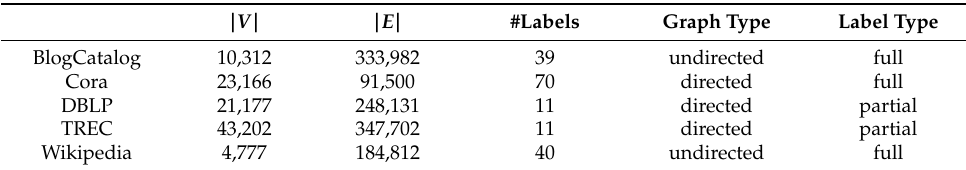
Table 1. Some statistics about our datasets. ∣ V ∣ ∣ E ∣ #Labels Graph Type Label